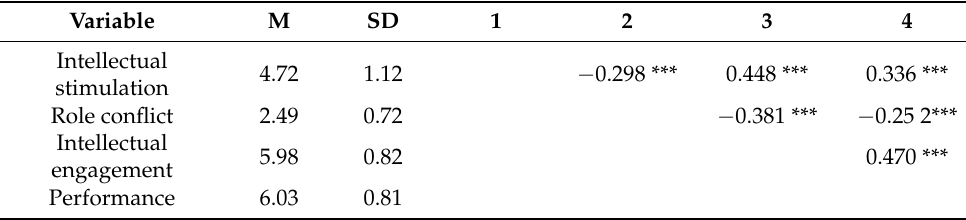
Table 1. Descriptive and